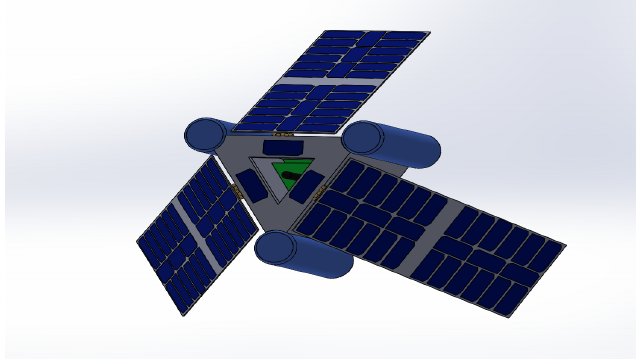
Figure 1. Deployment of satellite.